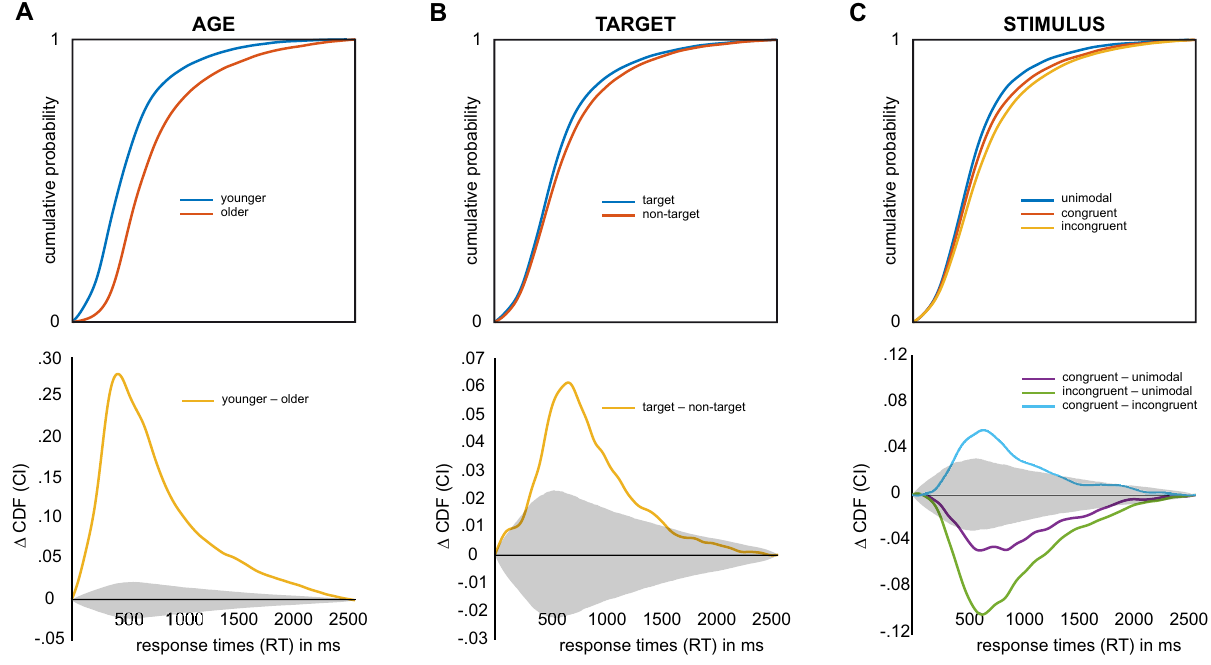
Figure 3. Main effects of AGE, TARGET and STIMULUS on cumulative distribution functions (CDFs) of response times (RTs). Grey shaded areas depict confidence intervals corrected for multiple testing. ( A ) (top) CDFs broken down by AGE. (bottom) Pairwise differences between AGE groups. ( B ) (top) CDFs broken down by TARGET. (bottom) Pairwise differences between TARGET conditions. ( C ) (top) CDFs broken down by STIMULUS. (bottom) Pairwise differences between STIMULUS